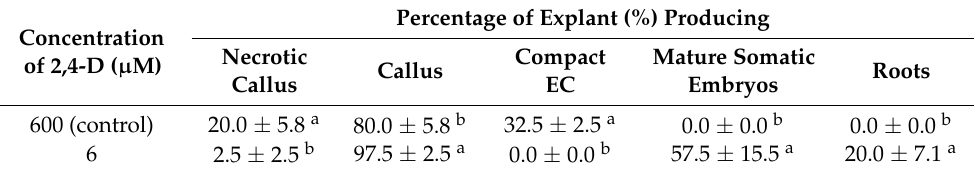
Table 1. The effect of 2,4-dichlorophenoxyacetic acid (2,4-D) concentration on various tissue produc- tion after 28 weeks of culture.